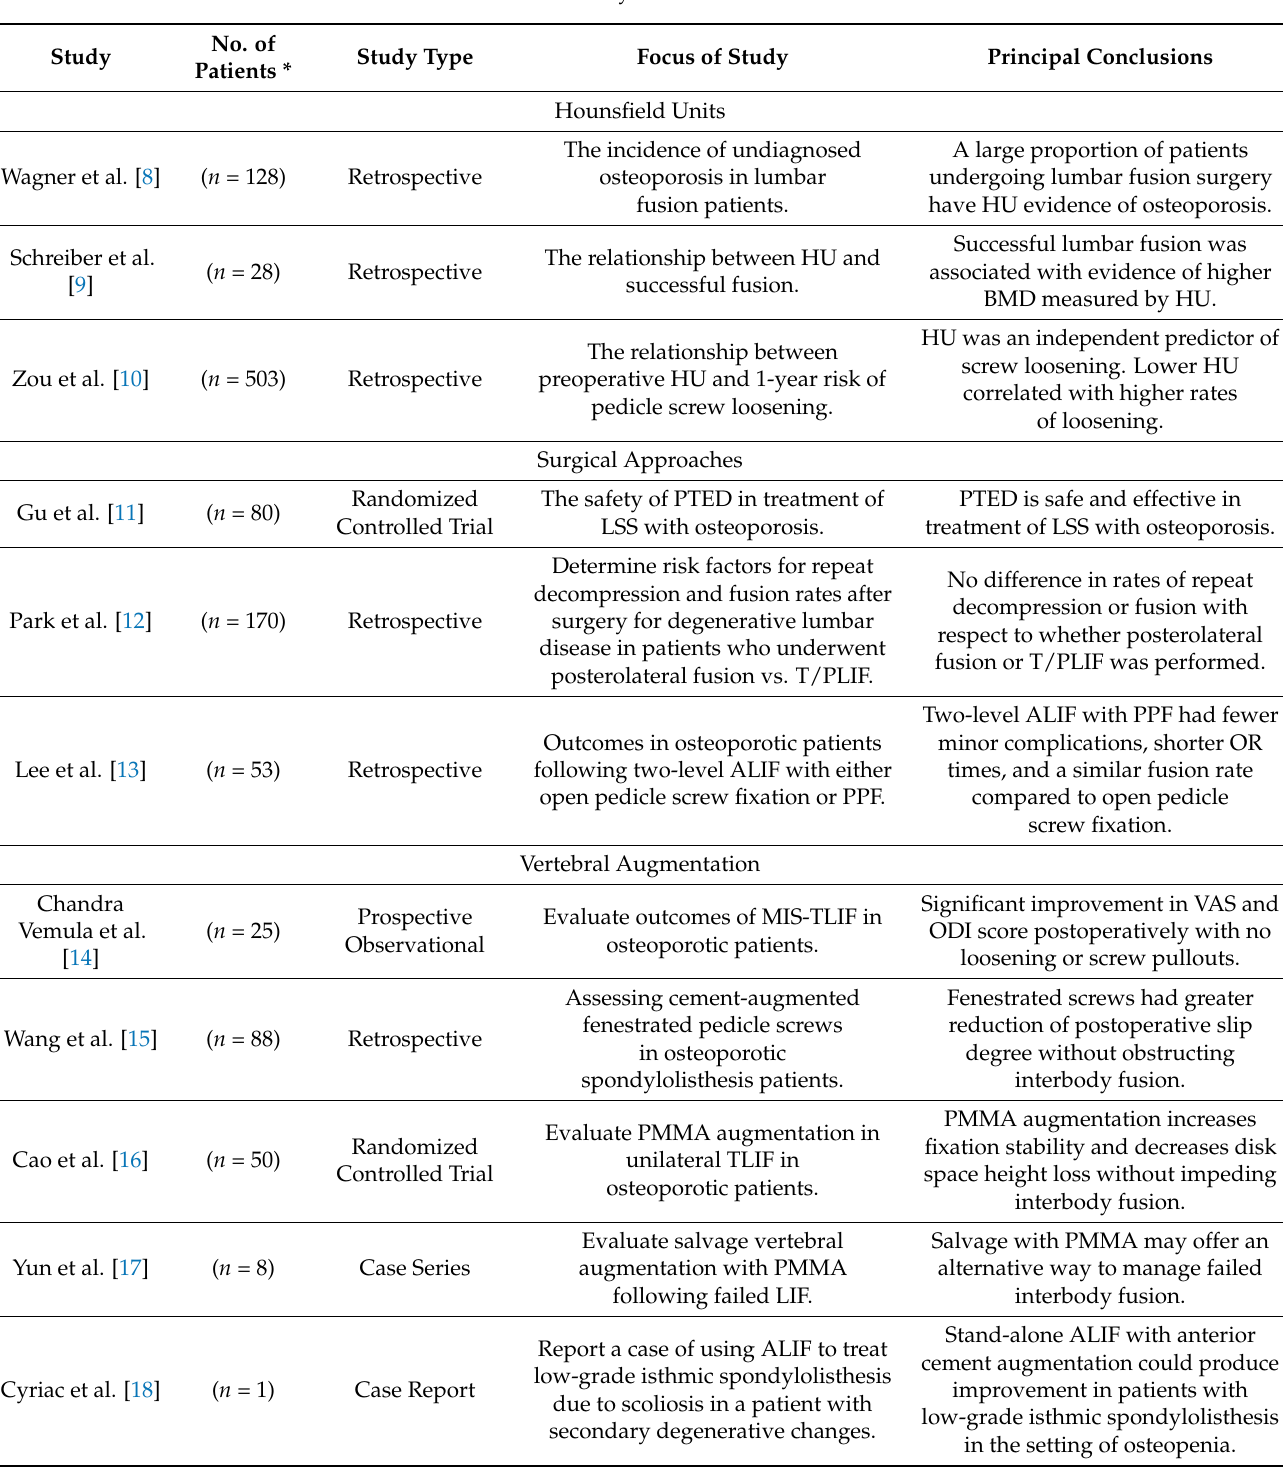
Table 1. Summary of studies